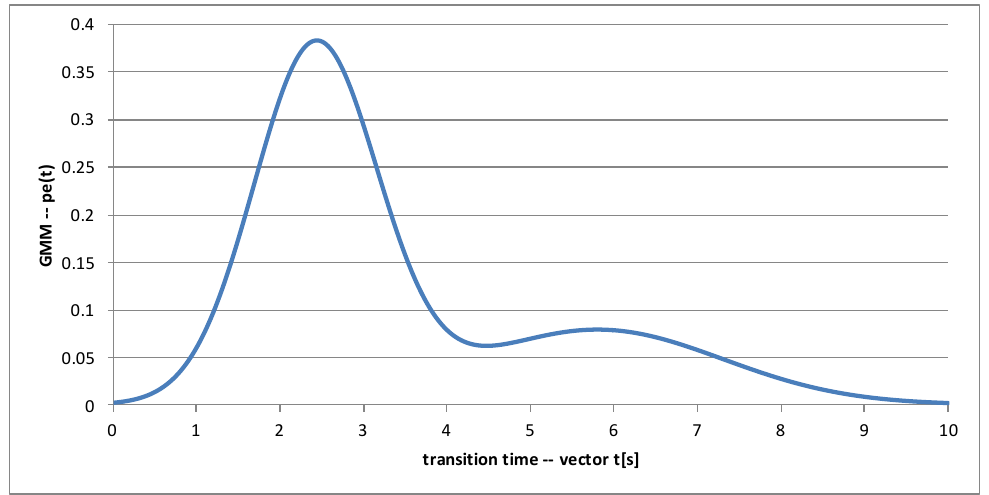
Figure 15. GMM after iteration k = 17 the EM algorithm ends because of termination criterion. The proposed mPSO is performed with the following parameters: δ rms = 0.0005,